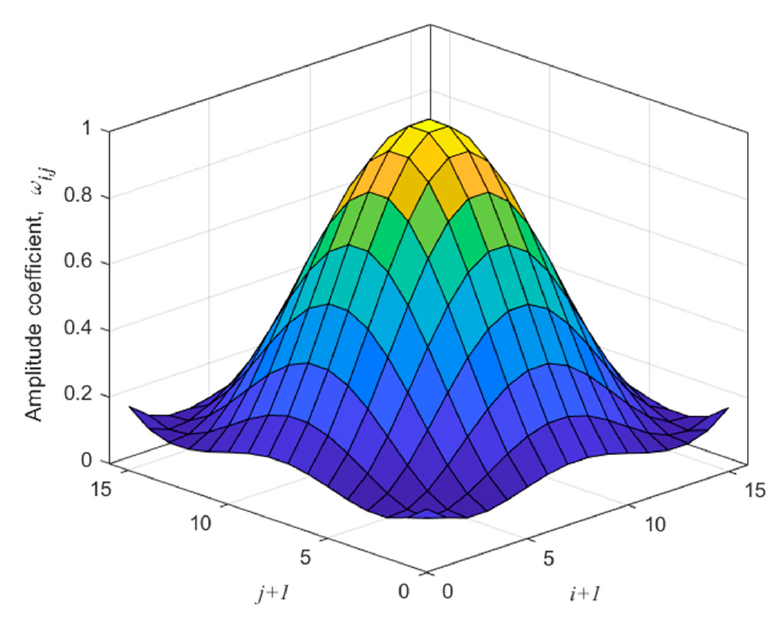
Figure 3. 2D extrapolated Hamming window for 16 × 16 array using radial tapering at µ = 0.85.